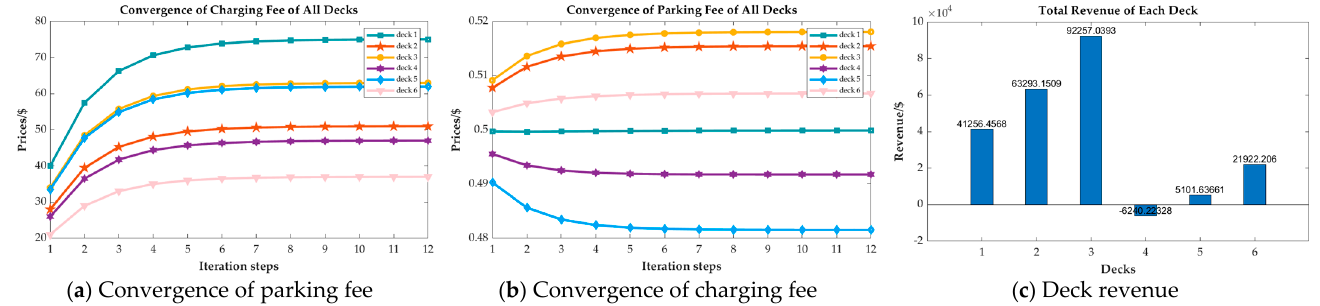
Figure 10. The electricity price, parking fee, and total revenue after halving the number of LSC cus- tomers in all decks and adding them to Group LC.